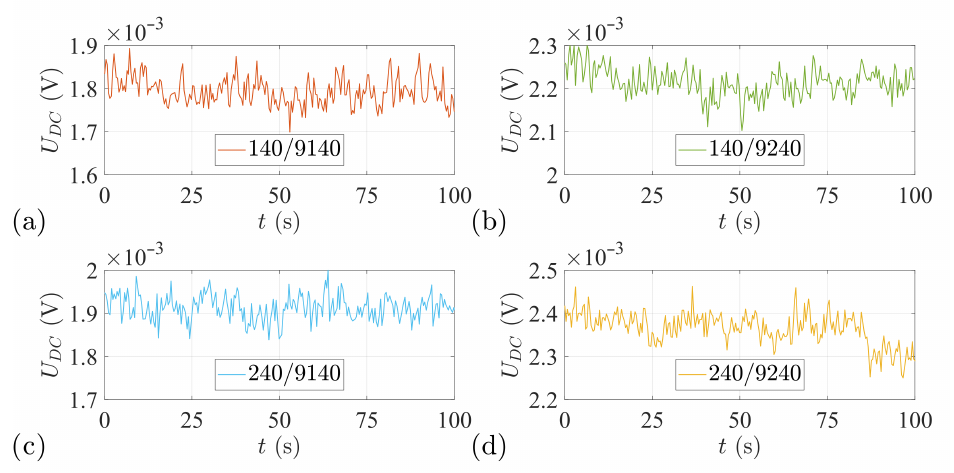
Figure 14. Voltage U DC measured for 15 W of output power at load R0: ( a ) 140/9140; ( b ) 140/9240; ( c ) 240/9140; and ( d ) 240/9240 transistor